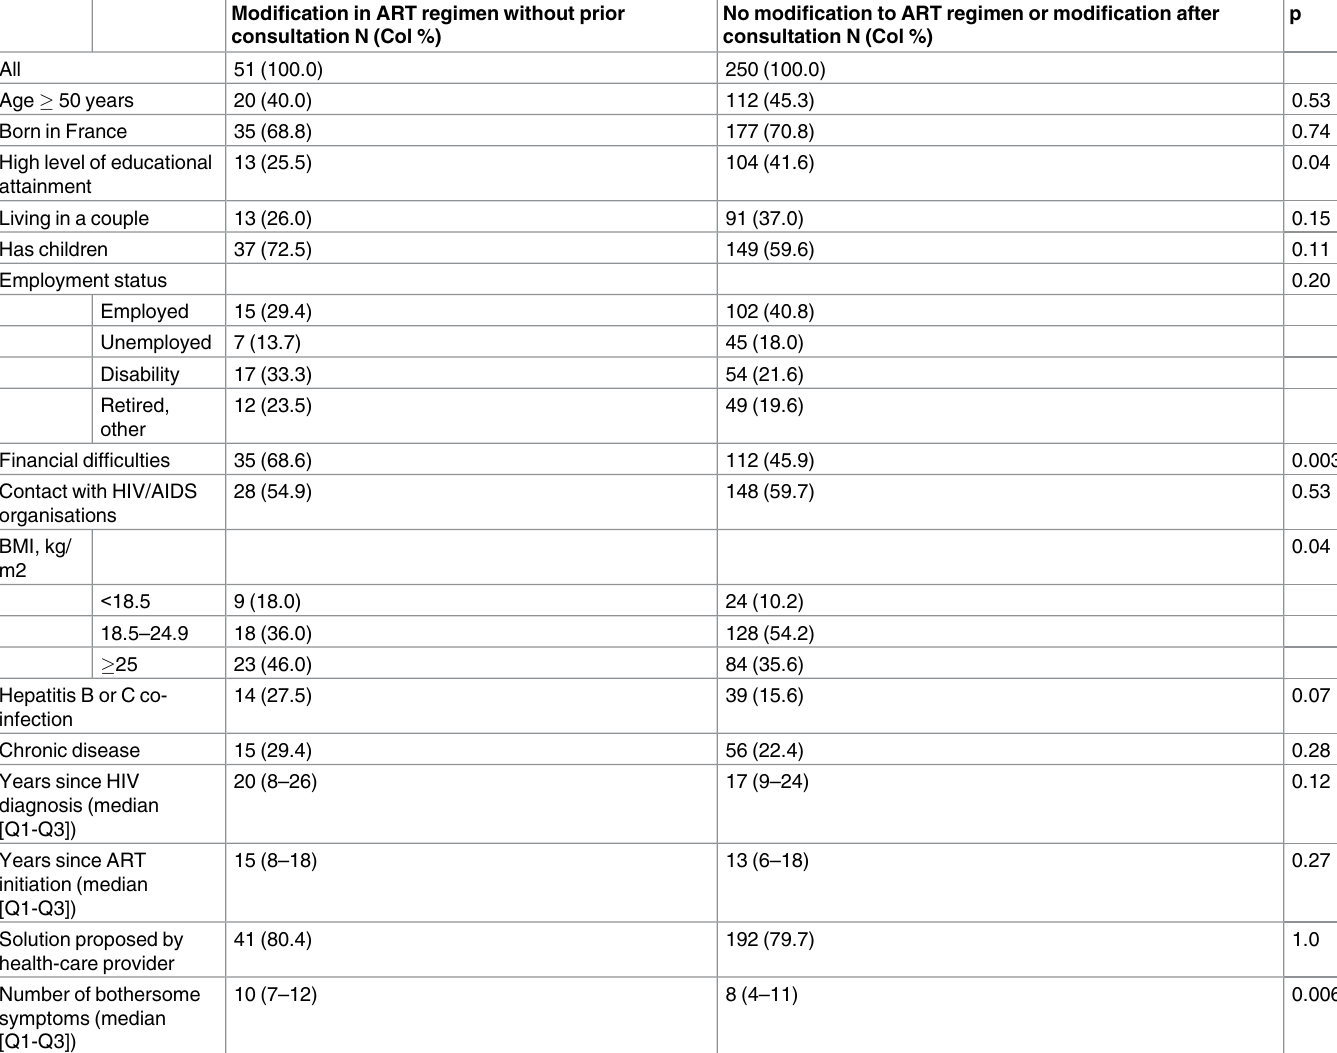
Table 3. Differencesin characteristics between women who reported having modified their ART regimen by decreasing the dosage or increasing the dosing intervals without prior consulting their health-care provider and those who did not: the EVE study (2014). Modification in ART regimen without prior consultation N (Col